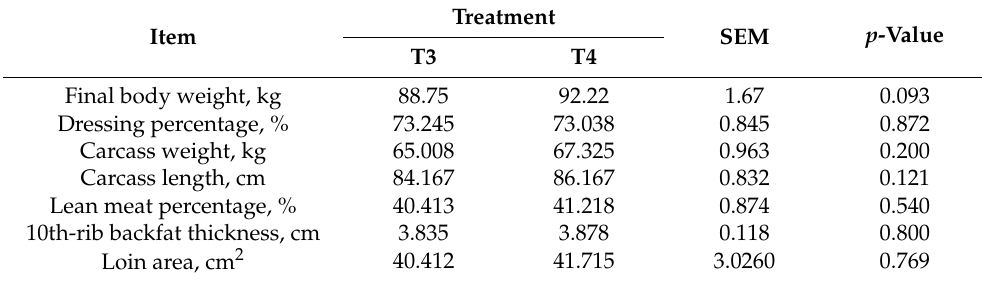
Table 7. Effect of dietary SID lysine levels on carcass characteristics of Baqing pigs.